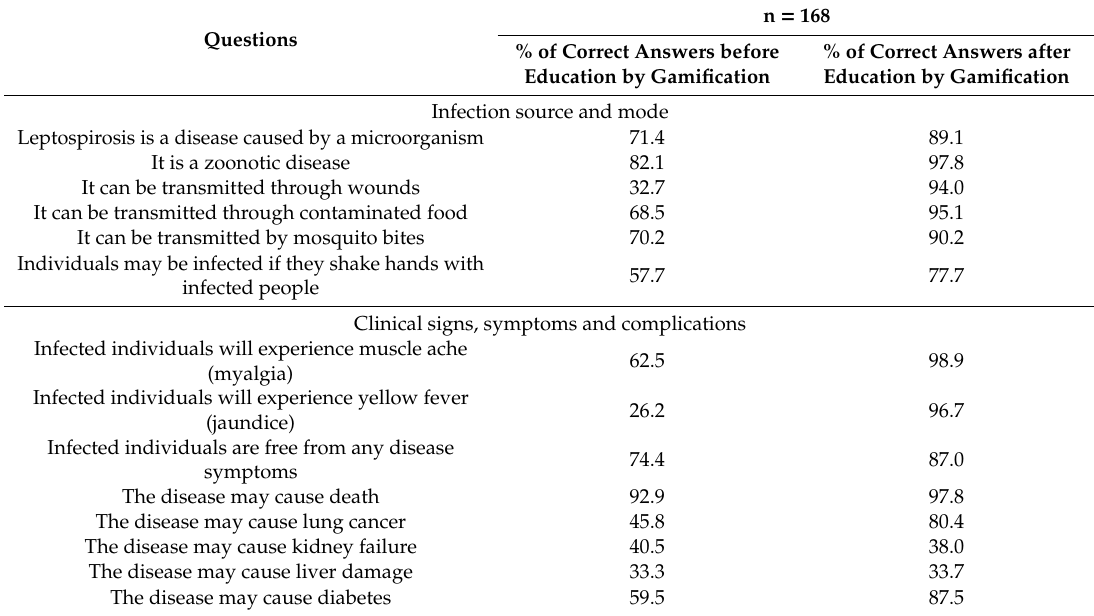
Table 2. List of questions asked to the respondents who had heard about leptospirosis during the gamification intervention, with the percentage scores for correct answers pre- and post-intervention (n =